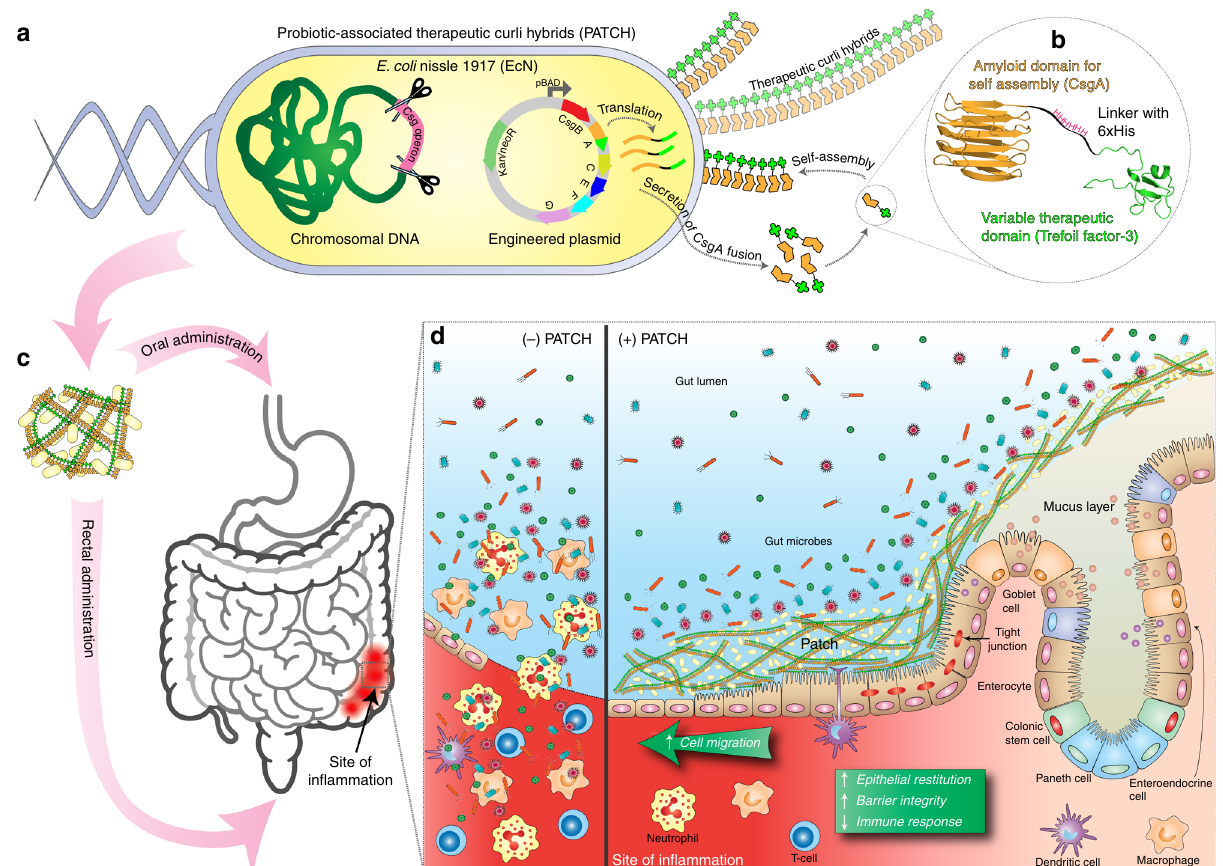
Fig. 1 Probiotic-associated therapeutic curli hybrids (PATCH). a Schematic overview of engineered curli production. Genetically engineered E. coli Nissle 1917 (EcN) with csg (curli) operon deletion (PBP8 strain) containing plasmids encoding a synthetic curli operon capable of producing chimeric CsgA proteins (yellow chevrons with appended bright green domains), which are secreted and self-assembled extracellularly into therapeutic curli hybrid fi bers. b CsgA (yellow), the main proteinaceous component of the E. coli bio fi lm matrix, was genetically fused to a therapeutic domain — in this case, TFF3 (PDB ID: 19ET, bright green), which is a cytokine secreted by mucus-producing cells. The fl exible linker (black) includes a 6xHis tag for detection purposes. c Engineered bacteria are produced in bulk before delivery to the subject via oral or rectal routes. A site of colonic in fl ammation is highlighted in red. d Interaction of PATCH and the colonic mucosa. In fl ammatory lesions in IBD result in loss of colonic crypt structure, damage to epithelial tissue, and compromised barrier integrity (left panel, ( − ) PATCH). The resulting invasion of luminal contents and recruitment of immune cells to the site exacerbates the local in fl ammation. The application of PATCH (right panel, ( + ) PATCH) reinforces barrier function, promotes epithelial restitution, and dampens in fl ammatory signaling to ameliorate IBD